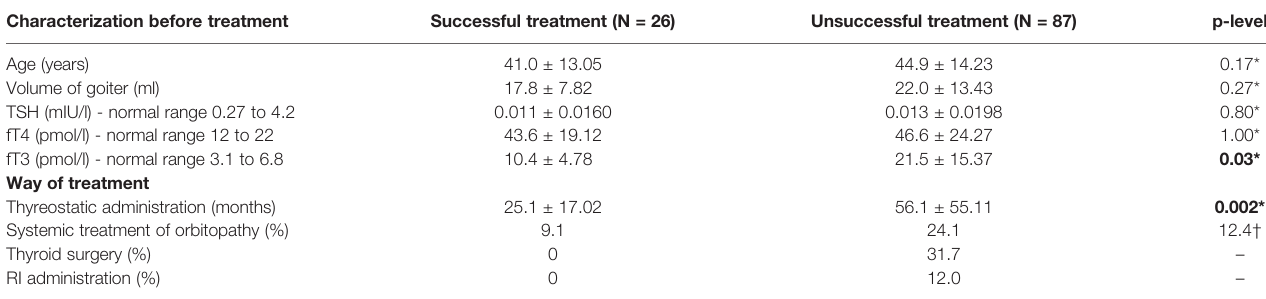
TABLE 2 | Comparison of patients with successful and unsuccessful conservative treatment. Characterization before treatment